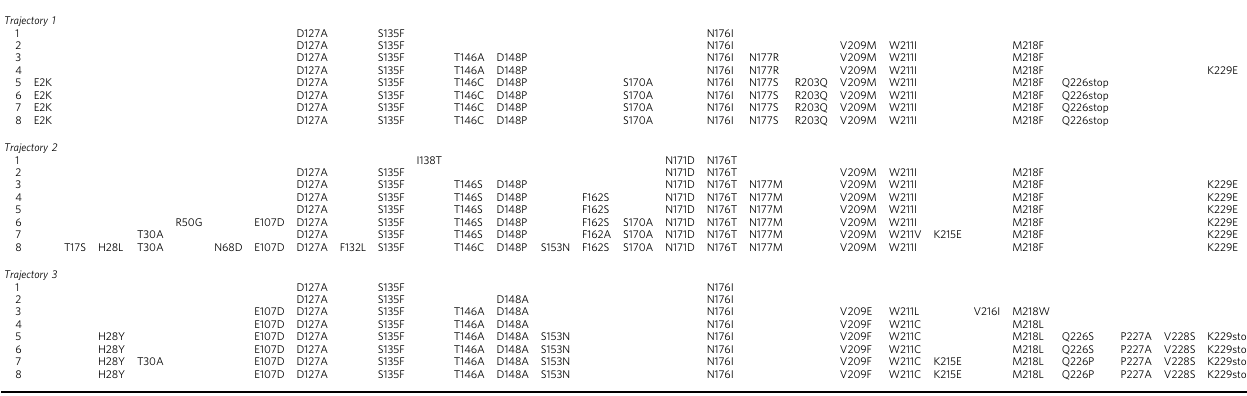
Table 1 Representative evolved TEV protease genotypes Trajectory 1